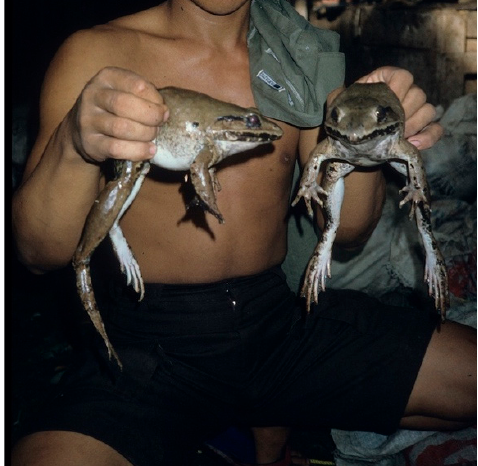
Figure 2. Two adult specimens of the Limnonectes blythii species complex from a large-scale collector in North Sumatra, 1996, © Mark Auliya; note: in 2004 the species was evaluated “Near Threatened”, in 2021 “Least Concern”; both assessments indicate a decreasing population trend (https://www.iu- cnredlist.org accessed on 1 November 2022); members of this complex are involved in domestic and international trade. In 2006, it was already found that this taxon was regionally overharvested, and in the 1980s, it was one of the dominant species that Indonesia exported to Europe [3,4].